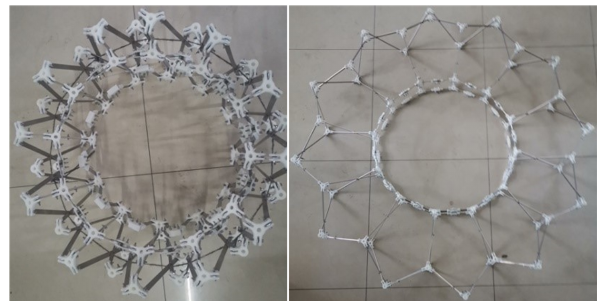
Figure 20. Prototype diagrams of scissor multi-rod